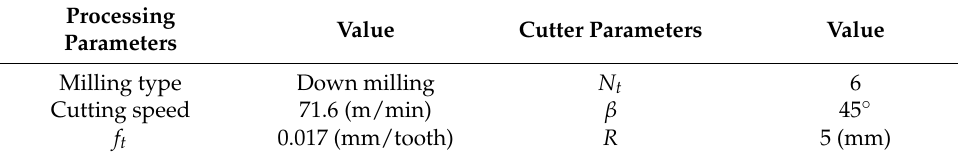
Table 3. Experimental conditions of the milling